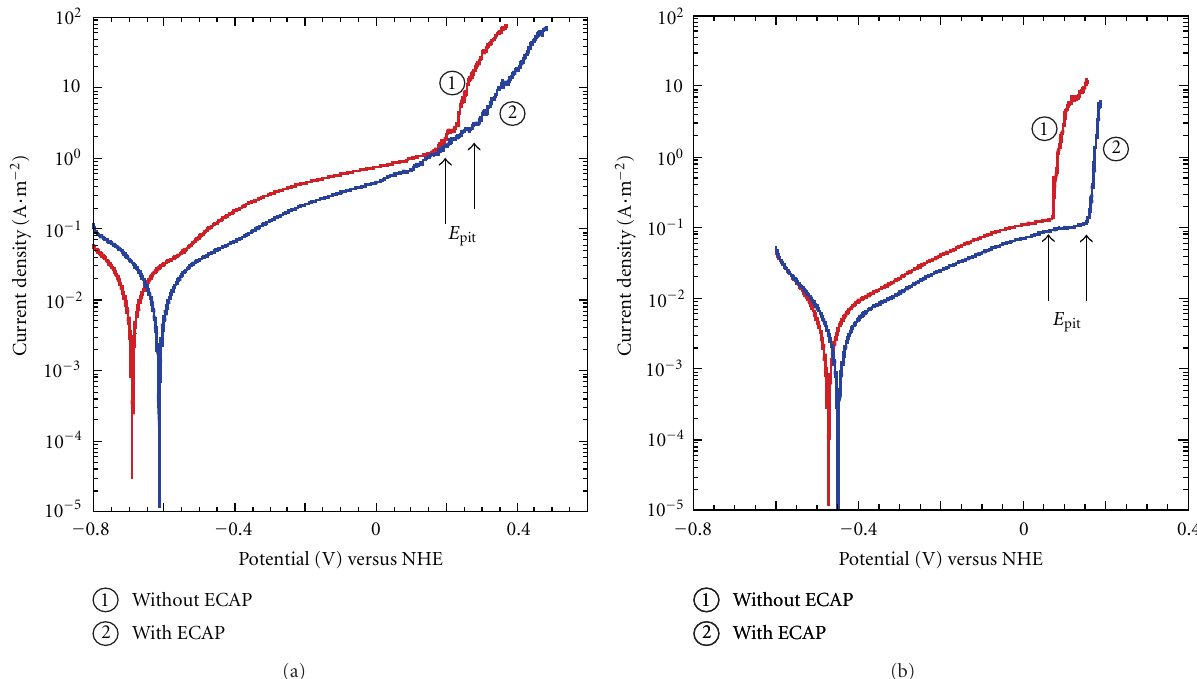
Figure 2: E ff ect of ECAP on the potentiodynamic polarization curves of pure Al (a) and Al (AA1100) (b) in a solution containing 0.1mol · dm − 3 of Na 2 SO 4 and 300 ppm of Cl −